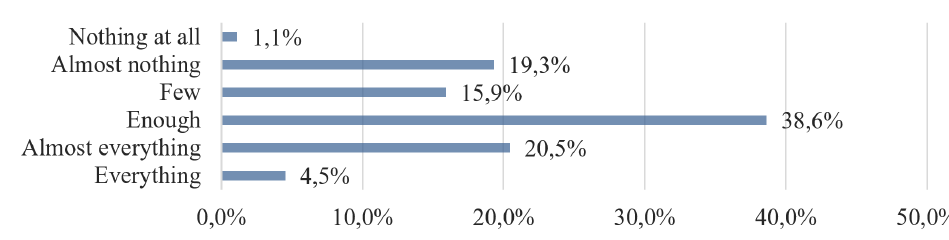
Figure 2. Ability to implement sustainable